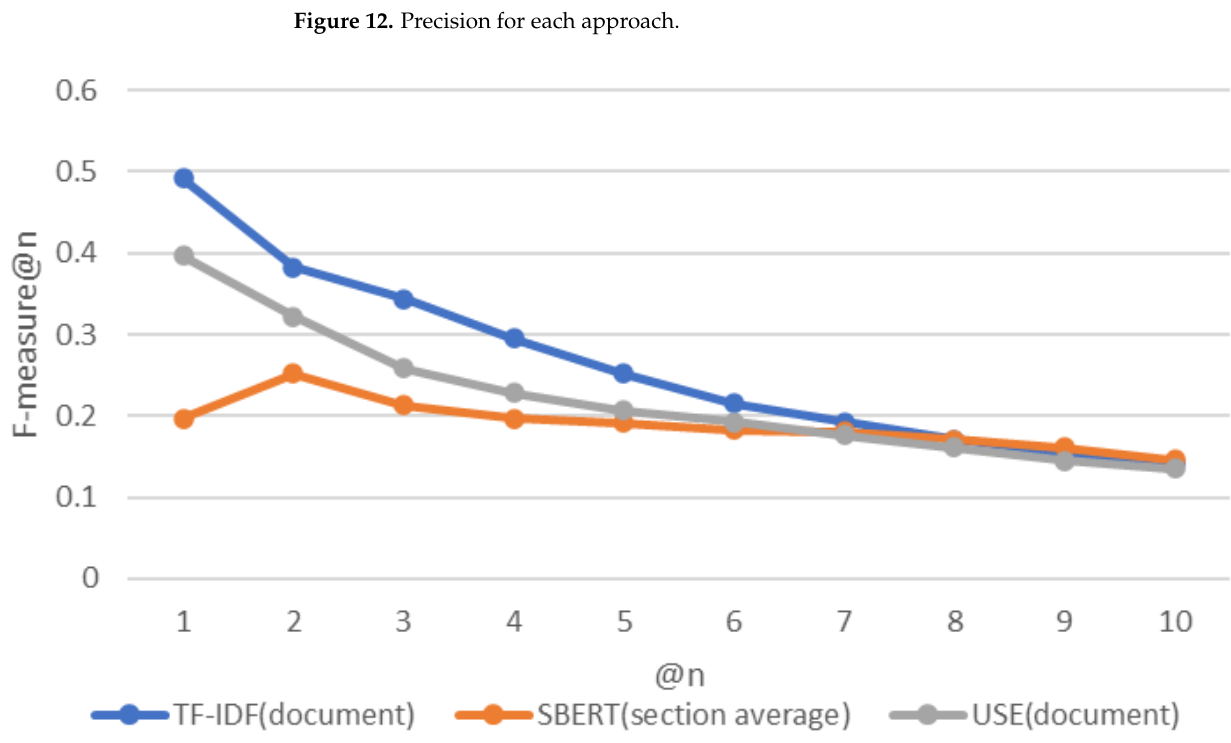
Figure 13. F-measure for each approach.